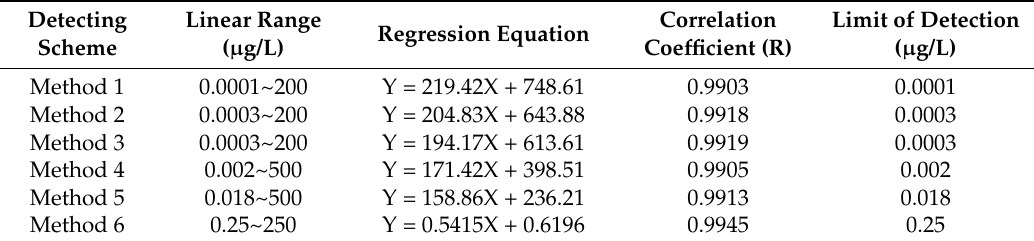
Figure 14. Comparison of five ECL immunosensors (Method 1: SPA-coated gold-magnetic nanoparticles coupled with pcAb capturing probe–toxins–Ru(bpy) 32+ -labeled phage displayed antibody luminescence probe detection scheme; Method 2: SPA-coated magnetic nanoparticles coupled with pcAb capturing probe–toxins–Ru(bpy) 32+ -labeled phage displayed antibody luminescence probe detection scheme; Method 3: gold-magnetic nanoparticles coupled with pcAb capturing probe–toxins–Ru(bpy) 32+ -labeled phage displayed antibody luminescence probe detection scheme; Method 4: SPA-coated gold-magnetic nanoparticles coupled with pcAb capturing probe–toxins–Ru(bpy) 32+ -labeled mcAb luminescence probe detection scheme; Method 5: magnetic nanoparticles coupled with pcAb capturing probe–toxins–Ru(bpy) 32+ -labeled mcAb luminescence probe detection scheme). Table 5. Comparison of five ECL immunosensor and ELISA (Method 1~5 see Figure 9; Method 6: conventional double-antibody sandwich ELISA.)